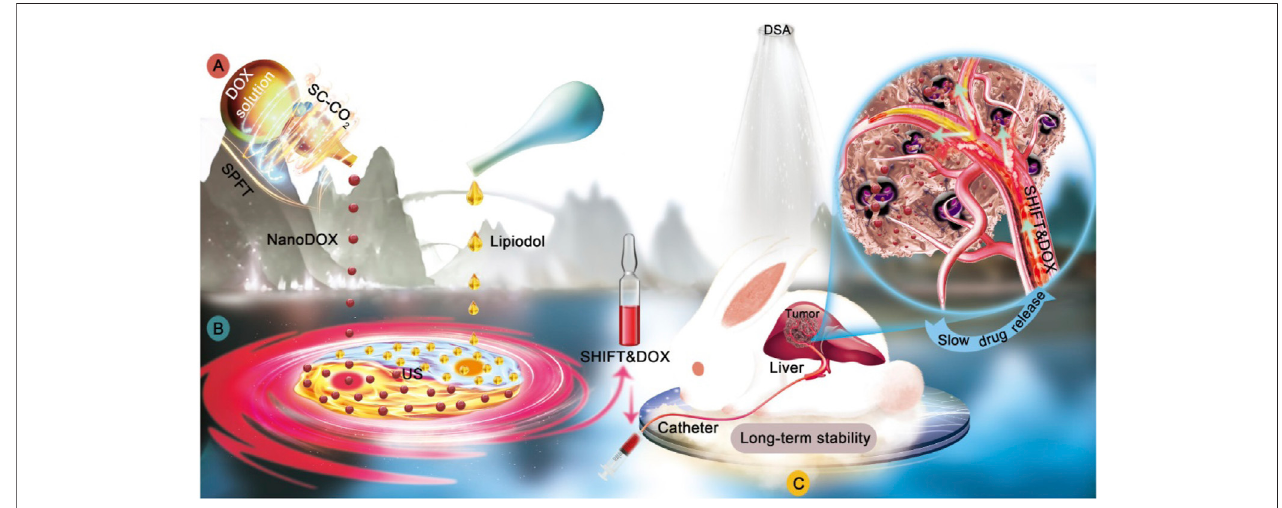
FIGURE 1 | Illustration of superstable homogeneous lipiodol-chemodrug formulation in TACE. (A) SPFT was applied to produce nanoDOX with a nanoscale size andexcellentuniformity. (B) nanoDOXwashomogeneouslydispersedintolipiodol vi aultrasonicationtoachievethesuperstablehomogeneouslipiodol-DOXformulation (SHIFT&DOX). (C) The SHIFT&DOX embolic formulation showed the sustained drug release and enhanced therapeutic effects. Reproduced with permission (He et al., 2022). Copyright 2022, Ivyspring International Publisher.